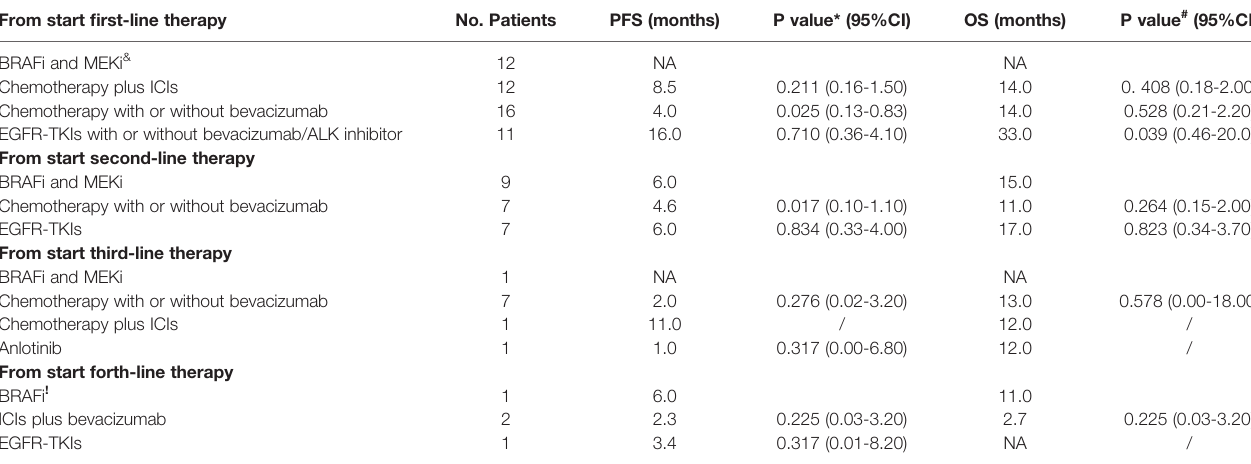
TABLE 2 | Outcome on First-and later lines of therapy. From start fi rst-line